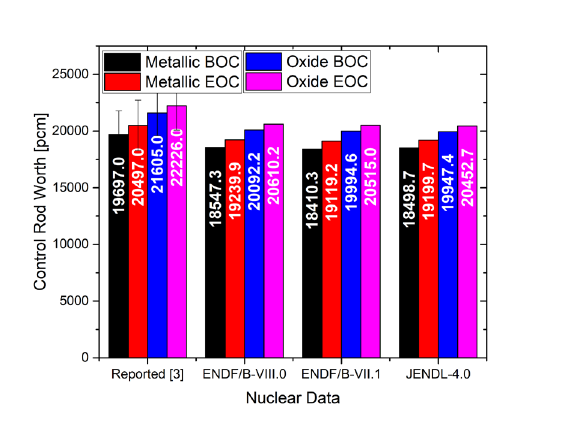
Figure 9. CR worth of both cores for di ff erent nuclear data li-